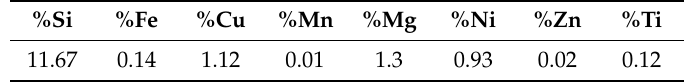
Table 1. Chemical composition range of AlSi12CuMgNi material (% in weight). Rest: Al